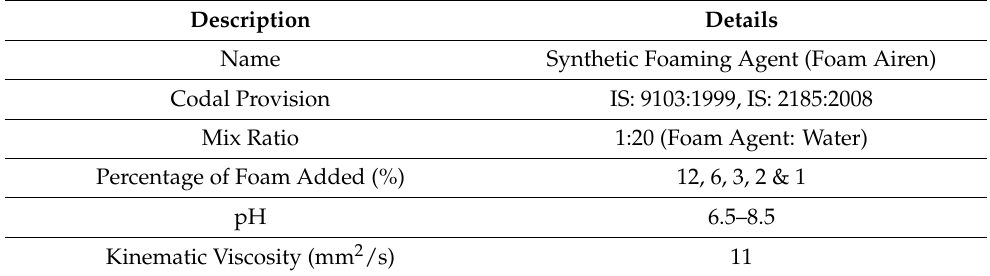
Table 5. Details of the Foaming Agent Used.